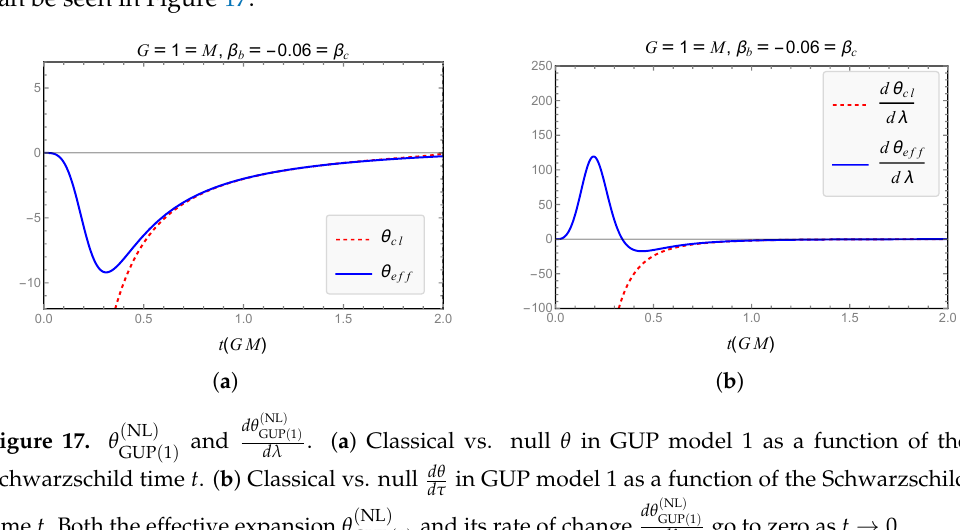
d θ ( NL ) GUP ( 1 ) go to zero as t → d λ